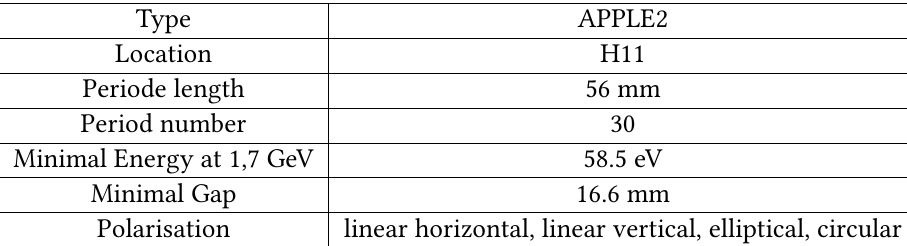
Table 1: Parameters of insertion device UE56-1.